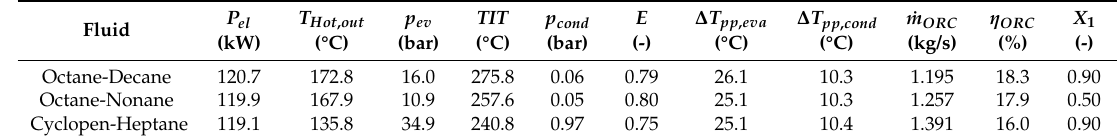
Table 7. Most promising mixtures using ICE measured data.